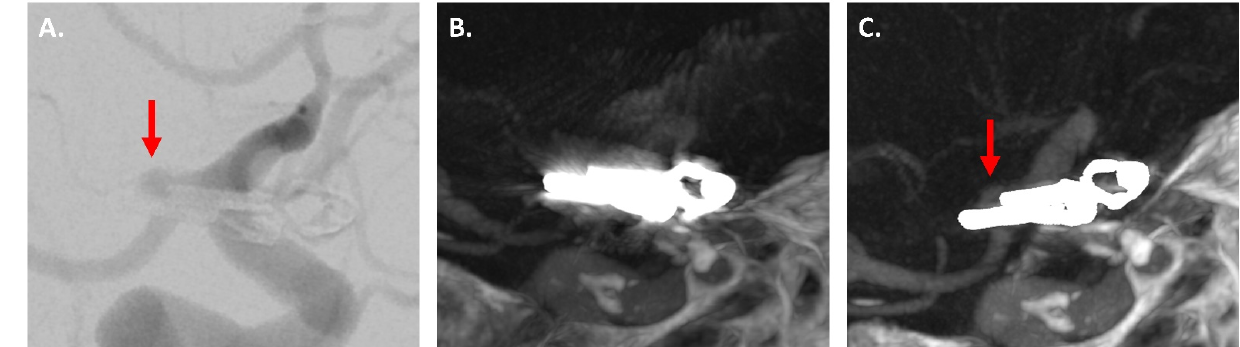
Figure 4. An 80 ‐ year ‐ old patient with an aneurysm of the right posterior communicating artery treated via intracranial clipping. DSA control revealed a small residuum at the aneurysm neck (( A ) red arrow). The aneurysm was not assessable in iMAR − FD ‐ CTA due to severe metal artifacts ( B ). After application of iMAR and the following significant metal artifact reduction, FD ‐ CTA also demonstrated the small residuum (( C ) red arrow).